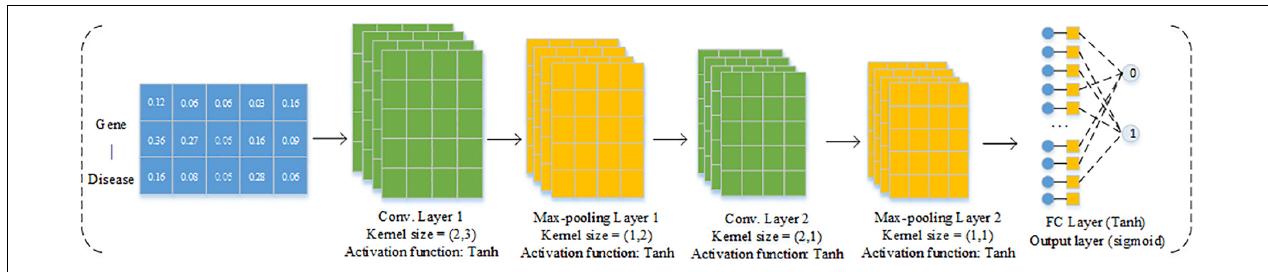
FIGURE 2 | Structure of CNN